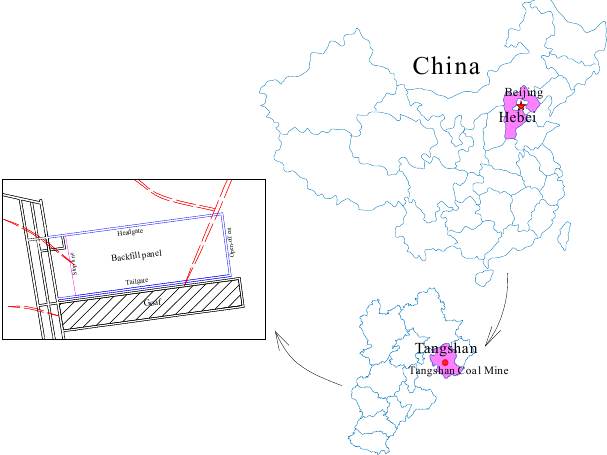
Figure 2. Crushed sandstone samples with different particle size distributions.